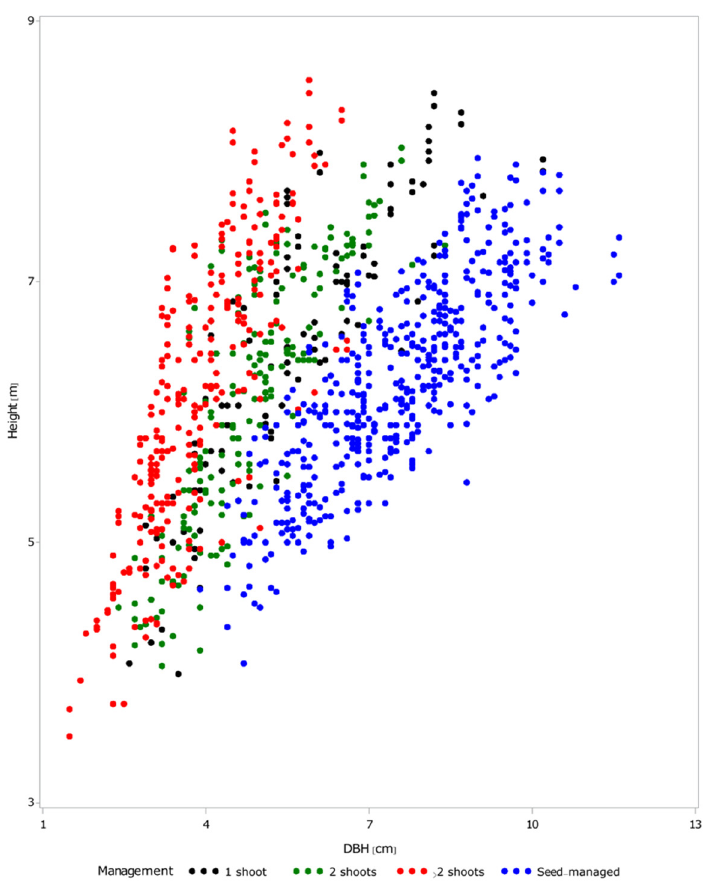
Figure 5. DBH–height relationship for stems younger than 144 months for the four management strategies: coppice with one shoot (red), coppice with two shoots (green), coppice with three or more shoots (black) and seed-managed trees (blue) .